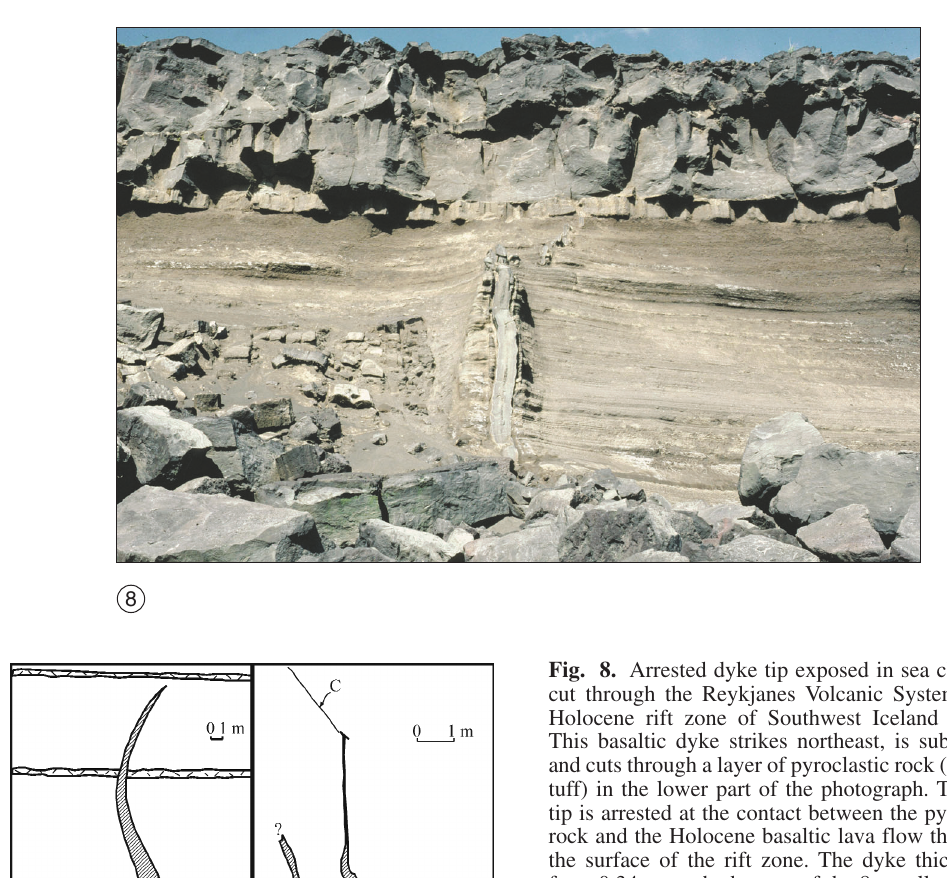
Fig. 8. Arrested dyke tip exposed in sea cliffs that cut through the Reykjanes Volcanic System in the Holocene rift zone of Southwest Iceland (fig. 5). This basaltic dyke strikes northeast, is subvertical, and cuts through a layer of pyroclastic rock (volcanic tuff) in the lower part of the photograph. The dyke tip is arrested at the contact between the pyroclastic rock and the Holocene basaltic lava flow that forms the surface of the rift zone. The dyke thickness is from 0.34 m, at the bottom of the 8 m tall exposure, to 0.1 m at the tip. There are no dyke-induced frac- tures or normal faults above the dyke tip. Fig. 9a-d. Four arrested dykes in the (14 Ma) basaltic lava pile of Northwest Iceland. In this schematic illustration, the dykes are shaded, the sco- ria layers between the lava flows are hatched, and the basaltic lava flows themselves are not shaded. The dykes occur in outcrops which are steep to vertical cliffs; the indicated scale is approximate. In (a) the dyke tapers away in the lava pile, in (b) the dyke tip is arrested at an oblique fracture (indicated by c) in a thick lava flow, in (c) the dyke has propagated for a short vertical distance into the bottom of the lava flow and expanded its arrested tip ( cf. fig. 3), and in (d) the dyke sends off a thin, vertical igneous vein in- to the bottom of a massive lava flow but otherwise expands and becomes arrested at the contact between the soft scoria layer and the stiff basaltic lava flow ( cf. fig.